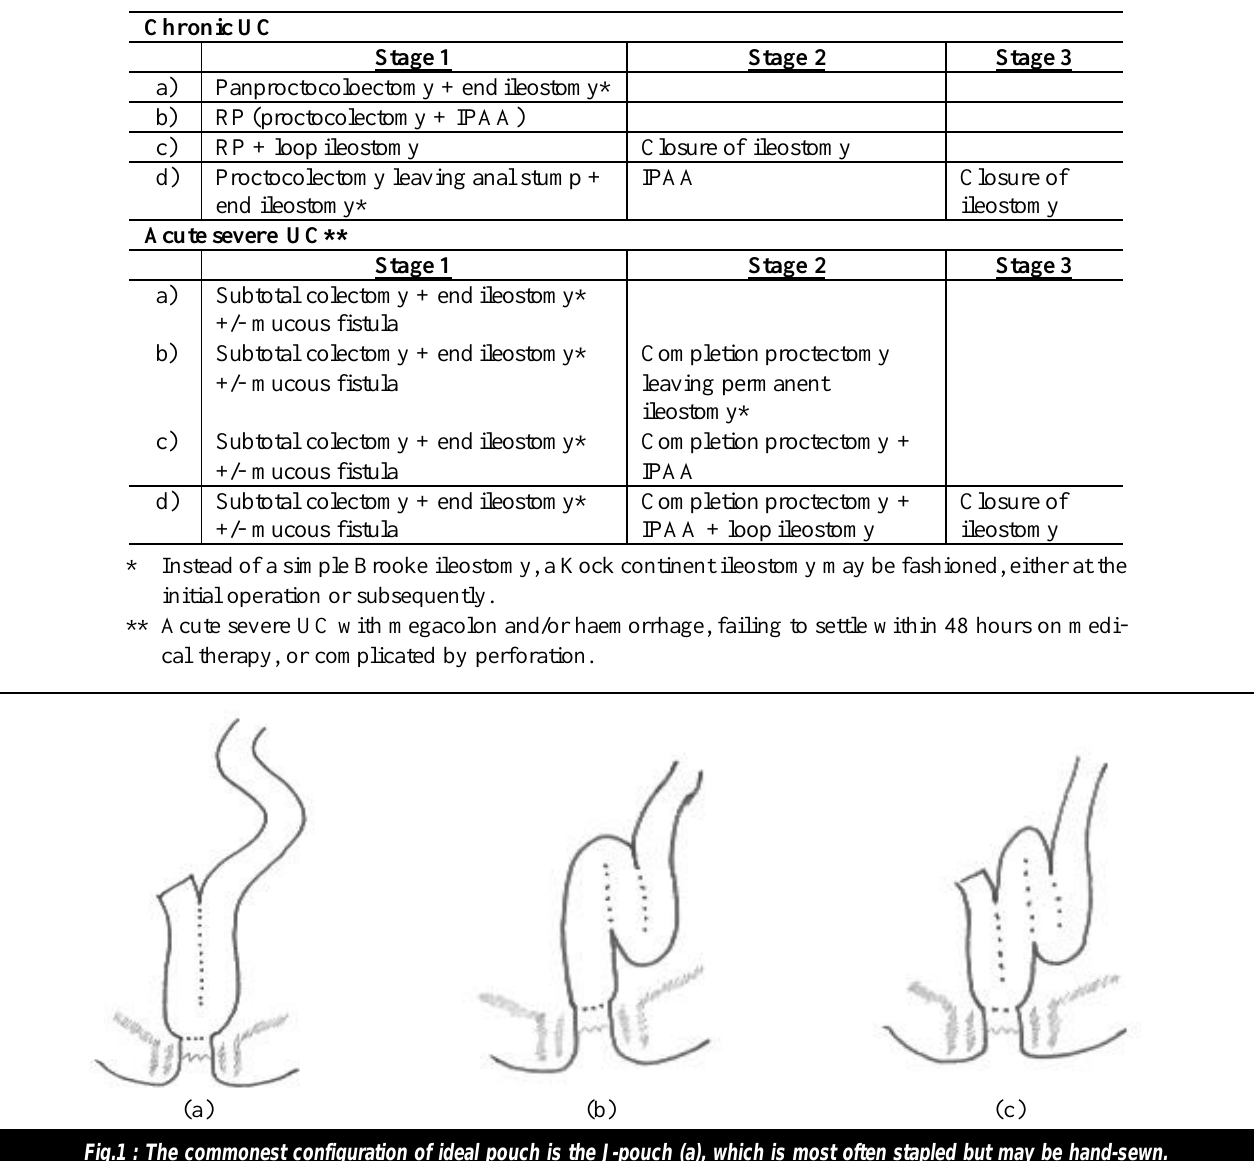
Table I : The surgical options in the management of chronic and acute severe UC, not responding to medical therapy